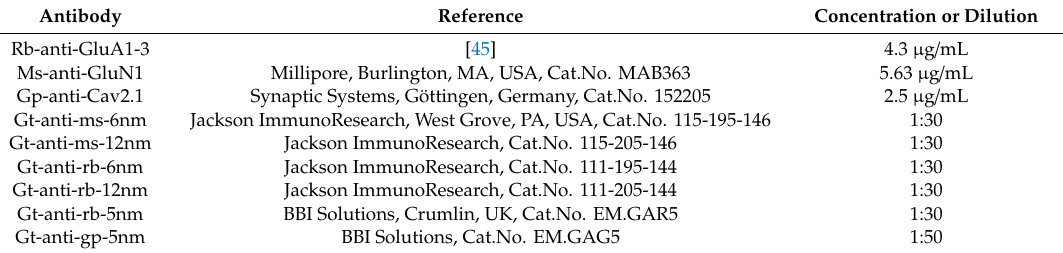
Table 1. Primary and secondary antibodies used in this